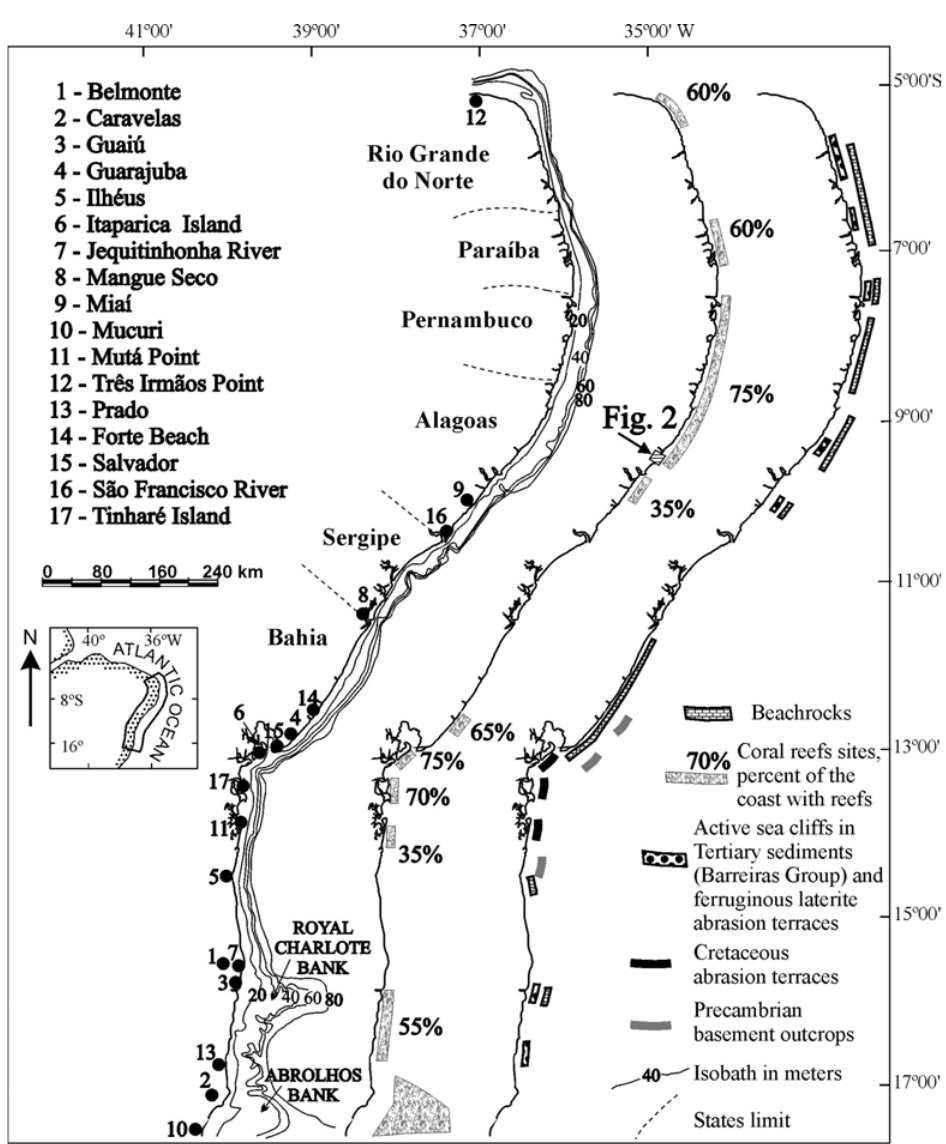
Fig. 1 – Location of major coral reef areas along northeastern and eastern Brazil illustrating the average percentage of reefs in each study area; the location of different types of rocky substrate outcrops along the coast; and the location of active sea